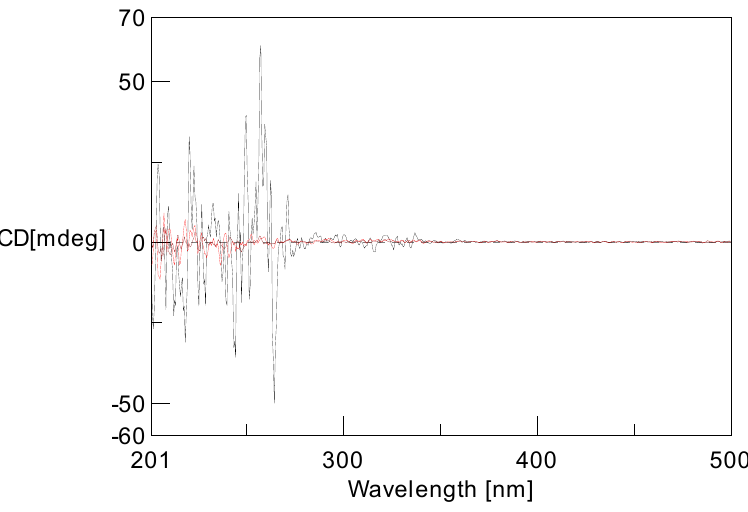
Figure 5. Experimental ECD spectra of 2